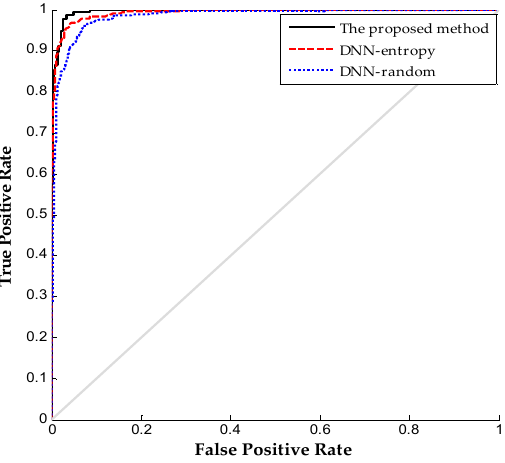
Figure 11. ROC (receiver operating characteristic curve) results comparison on different method.